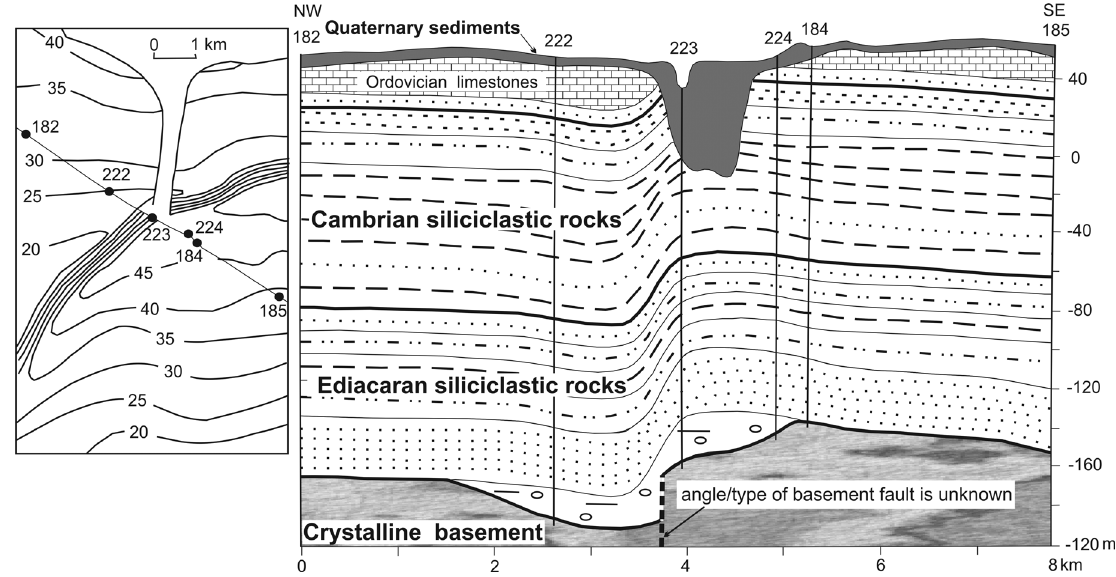
Fig. 7. Geological cross section across the Aseri basement fault (with a detailed excerpt of the structure contour map of the platform cover) showing the monoclinal forced fold in the overlying platform cover (modified after Puura & Vaher 1997). For location see Fig.